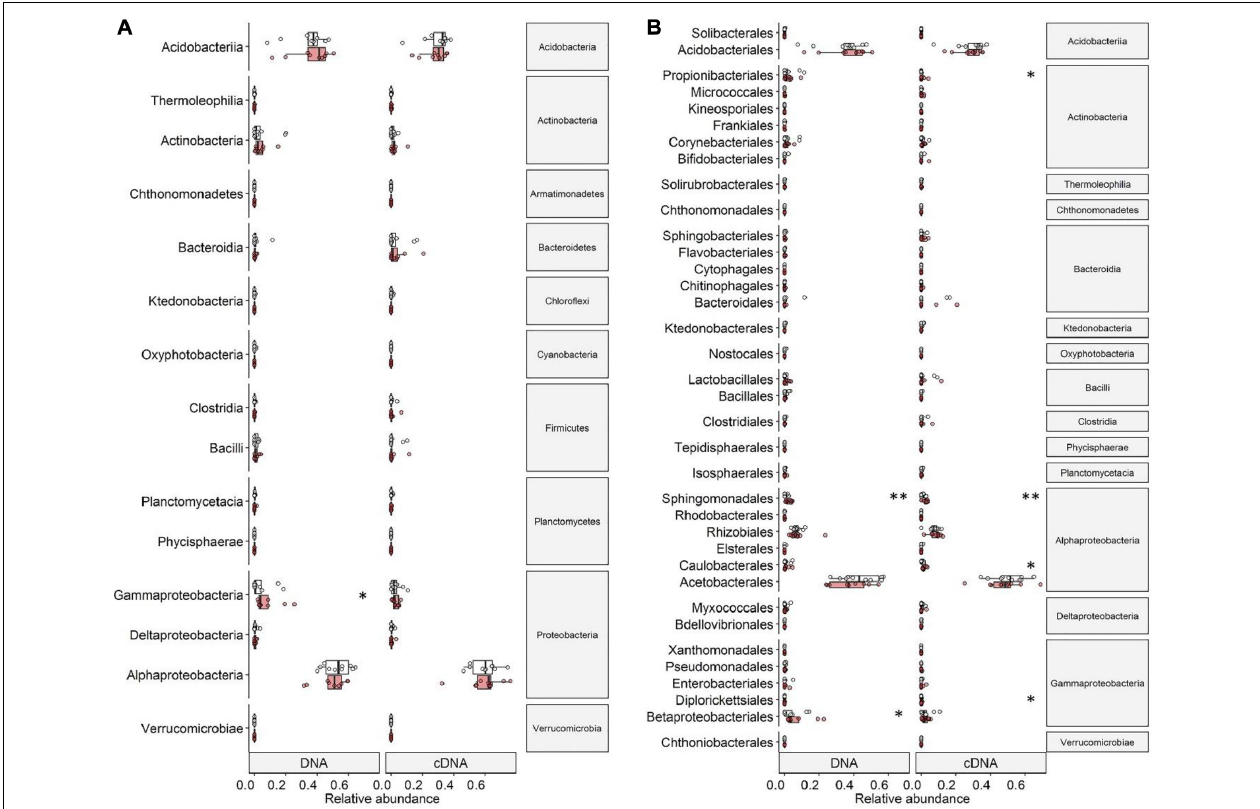
FIGURE 4 | Relative abundances of (A) classes and (B) orders of DNA- and cDNA-based bacterial communities associated with the lichen C. islandica in control (white) and warmed (red) samples. Points indicate average relative abundance values per control or warmed plot. Boxplots represent minimum values, first quartiles, medians, third quartiles, and maximum values. Significance levels ( ∗ p < 0.05 and ∗∗ p < 0.01) are based on Wilcoxon rank-sum